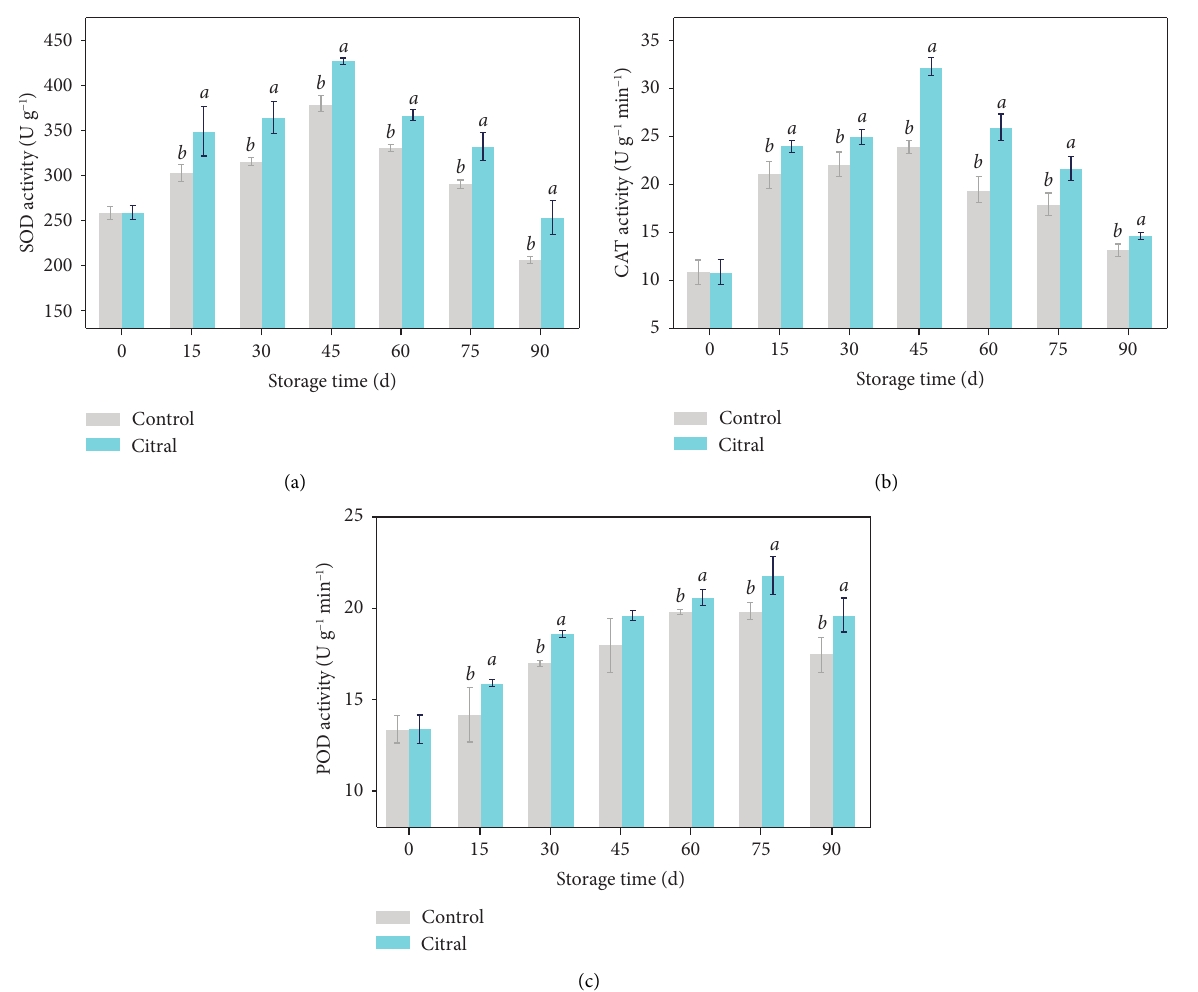
Figure 5: Effect of citral treatment on the activities of superoxide dismutase (SOD), (a) catalase (CAT), (b) and peroxidase (POD) (c) of harvested kiwifruit stored at 0-1 ° C for 90d. Vertical bars represent the mean ± standard error (S.E., n � 3). Letters indicate the statistical differences according to the independent samples t -test ( p < 0 . 05) on each storage